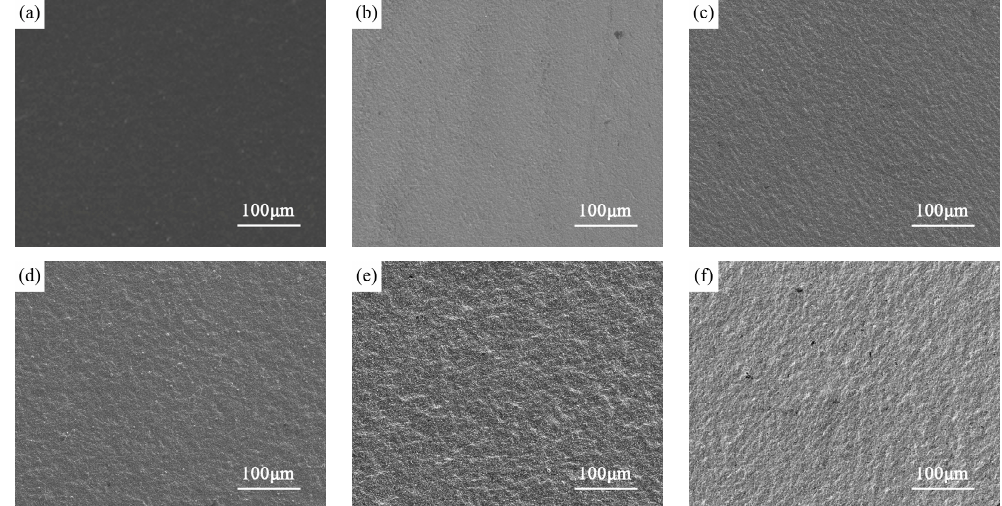
Figure 1. Surface morphology of titanium test samples after ( a ) polished (P), ( b ) plasma nitriding at 750 °C (750N), ( c ) plasma nitriding at 800 °C (800N), ( d ) plasma nitriding at 850 °C (850N), ( e ) plasma nitriding at 900 °C (900N), and ( f ) plasma nitriding at 950 °C (950N).